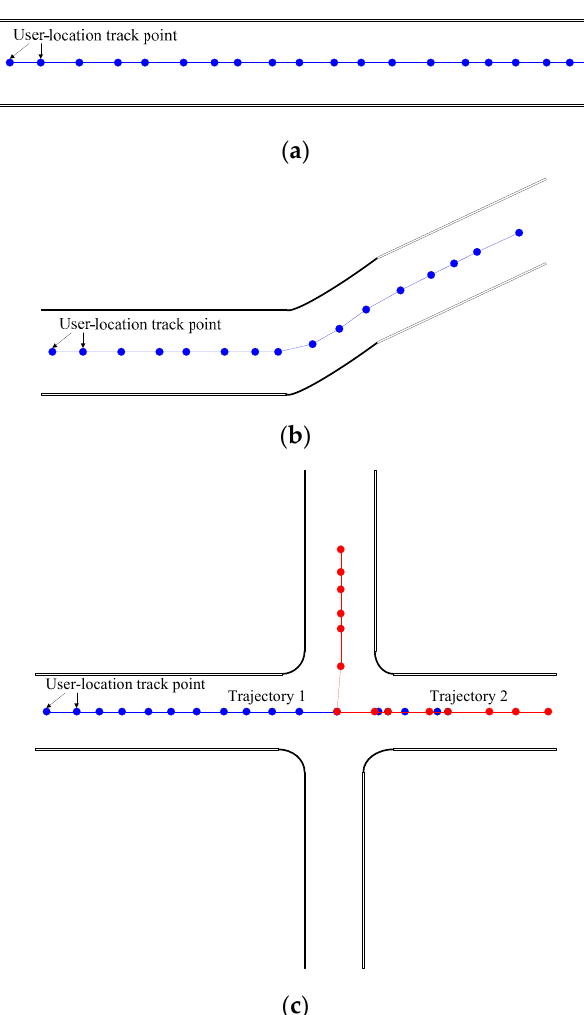
Figure 2. Diagram of user-location track: ( a ) straight-line tunnel; ( b ) irregular linear tunnel; ( c ) tunnel with